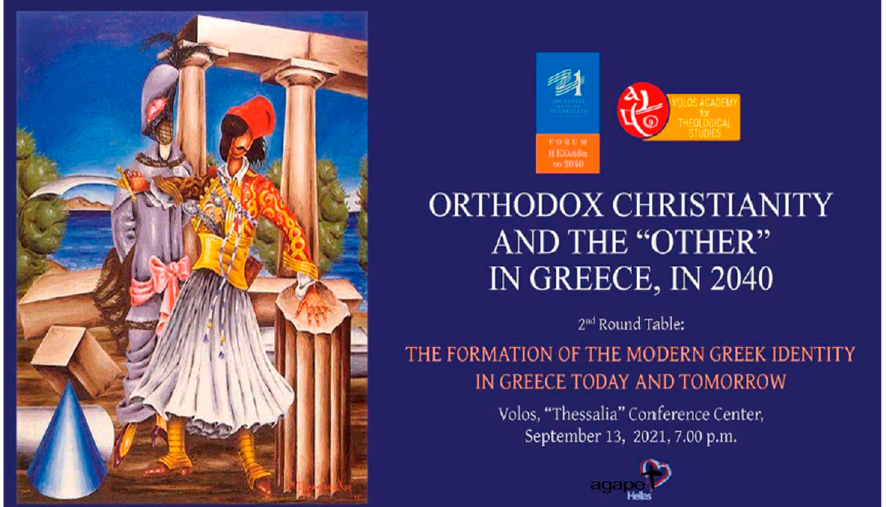
Figure 2. Screenshot by the author from https://acadimia.org/en/news-announcements/press/893-the-formation-of-the-modern-greek-identity-in-greece-today-and-tomorrow (accessed on 15 October 2021).